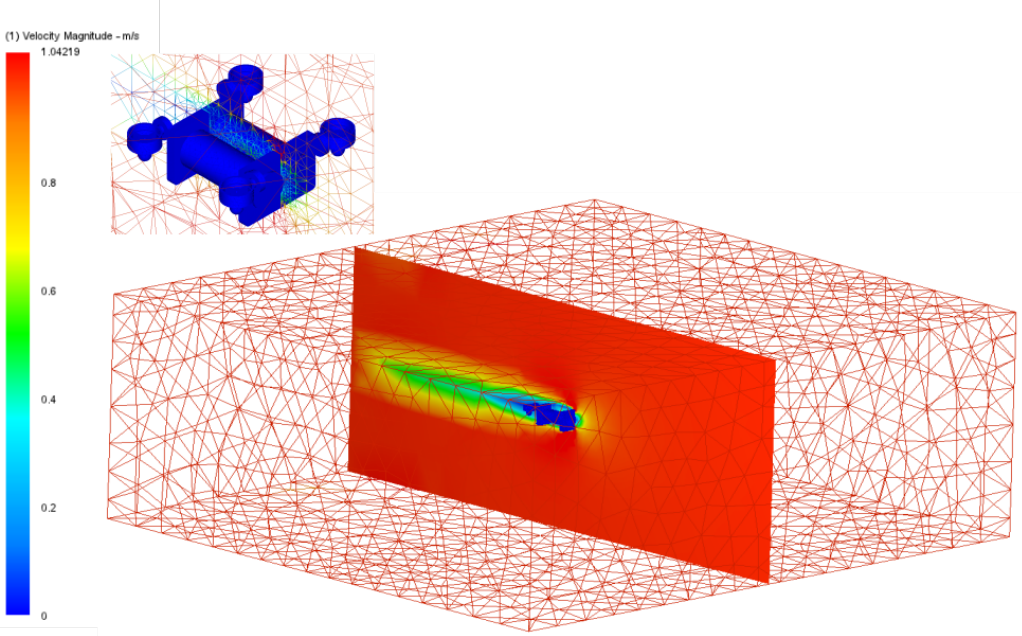
Figure 14. The mesh used in the simulation of the Autodesk CFD software. The size corresponds to the volume used for the fluid, which is considered to have a distance of at least 10 times the length of the robot on that axis. At the top, the variation of the triangle size in the mesh near to the robot is shown. The robot is in blue.